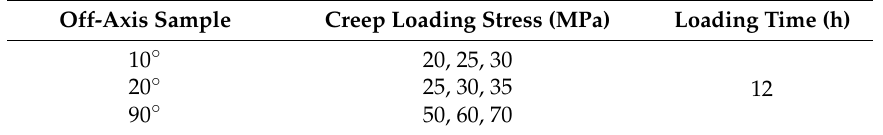
Table 1. Tensile creep testing plan for off-axis samples of quasi-UD E-glass/polypropylene composite.